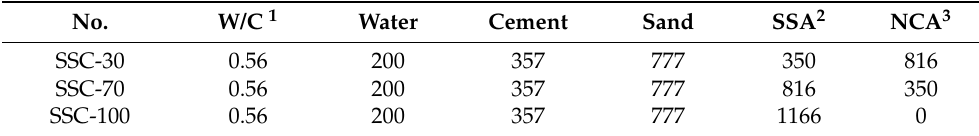
Table 2. Mix proportions and major parameters of concrete (kg/m 3 ).